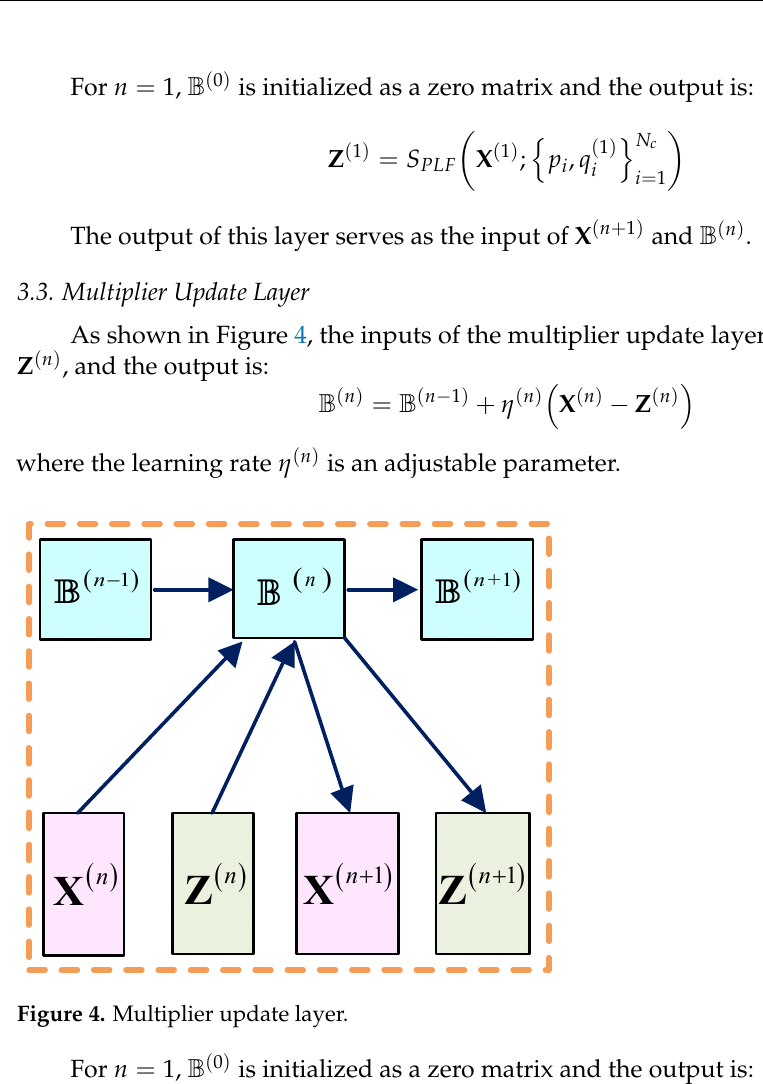
  n  Figure 3. Nonlinear transform layer. For